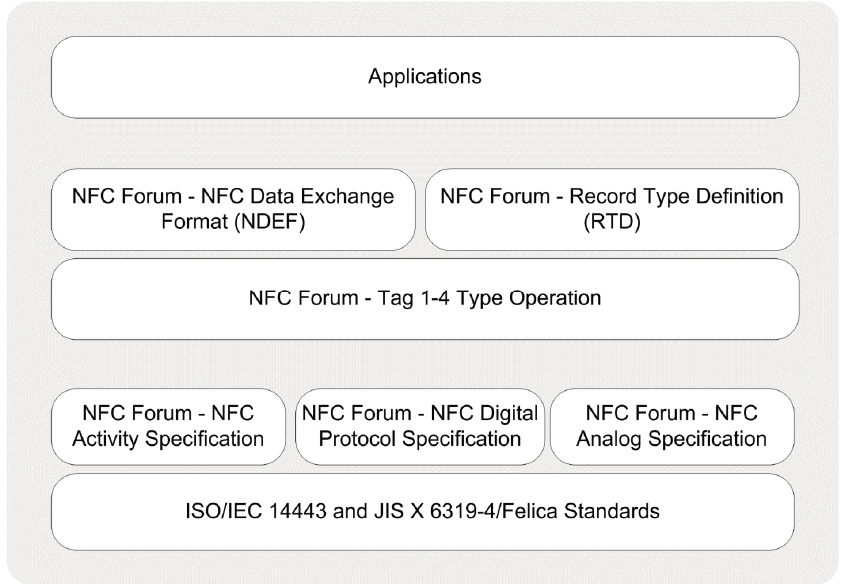
Figure 3. Protocol stack of reader/writer operating